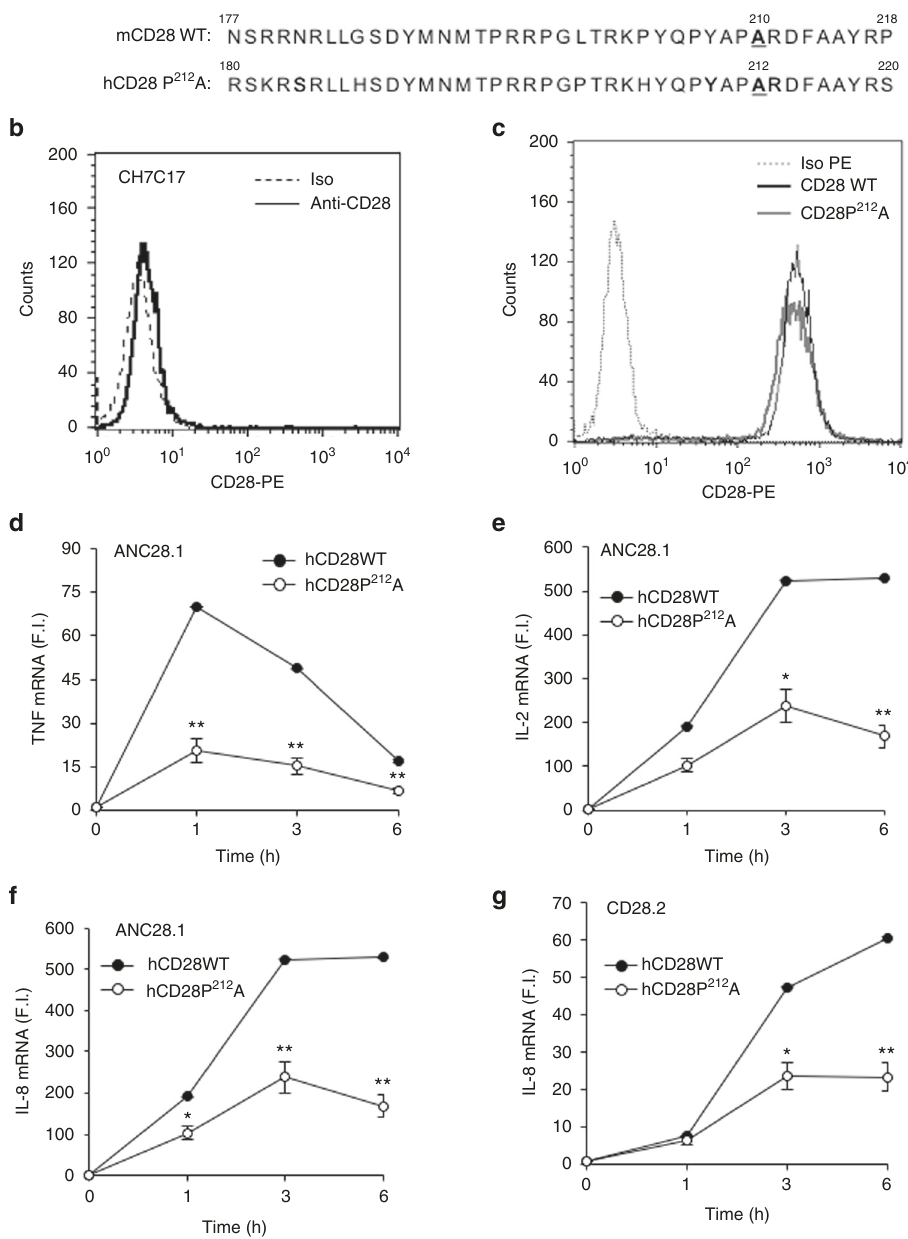
Fig. 3 P 212 residue within the C-terminal proline-rich motif (YQPP 212 ) of human CD28 is essential for CD28-mediated upregulation of pro-in fl ammatory cytokines. a Amino acid sequence of human (hCD28) and mouse CD28 WT (mCD28) and mutants. The substitution P 212 A in hCD28 is indicated in bold. b , c FACS analysis of CD28-negative CH7C17 Jurkat T cell line ( b ), or CH7C17 cells expressing hCD28WT or hCD28P 212 A mutant ( c ) stained with phycoerythrin (PE)-conjugated isotype control (Iso) or anti-CD28 (CD28-PE) Abs. d – g CH7C17 cells expressing CD28WT or hCD28P 212 A mutant were stimulated with 2 μ g ml − 1 crosslinked ANC28.1 ( d – f ) or CD28.2 Abs ( g ). TNF ( d ), IL-2 ( e ), and IL-8 ( f , g ) mRNA levels were measured by real-time PCR and values, normalised to GAPDH, were expressed as fold inductions (F.I.) over the basal level of cells stimulated with control Ig. Bars show the mean ± SD of one experiment representative of three. Statistical signi fi cance was calculated by Student ’ s t- test. * p < 0.05, ** p <